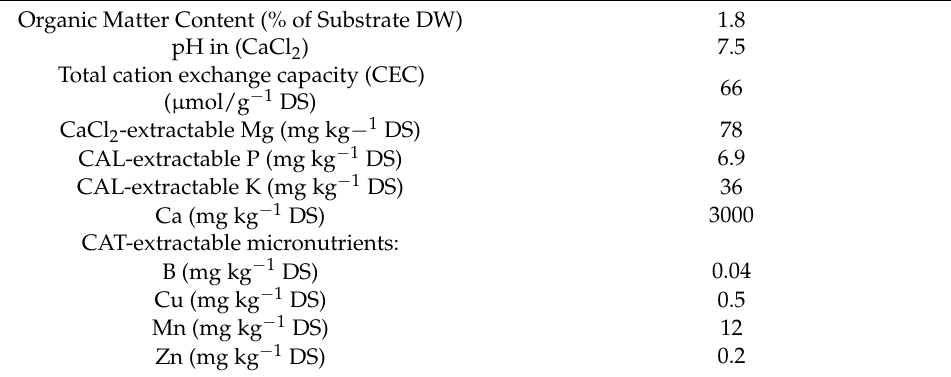
Table A1. Properties of the mixture substrate.